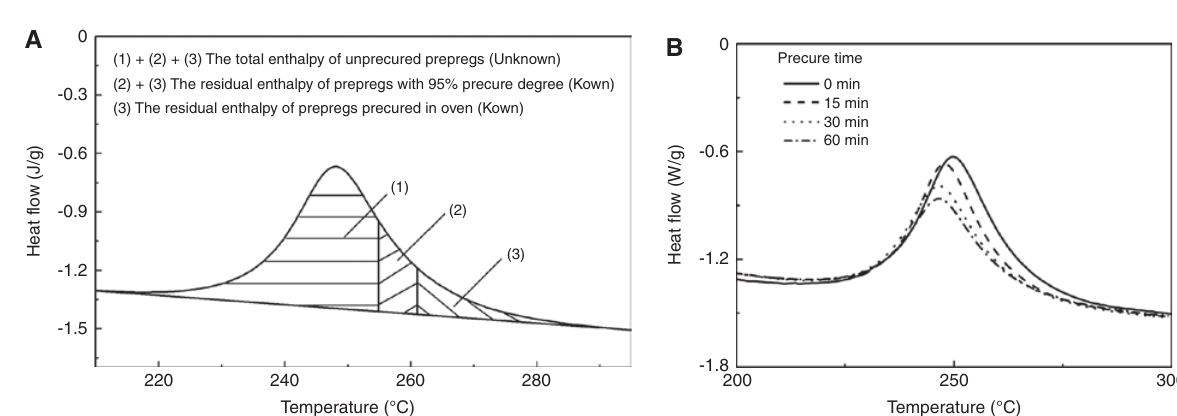
Figure 2: DSC curves for benzoxazine resin (A) showing the total enthalpy of prepregs without precure from a slow temperature scan, (B) showing the residual enthalpy of prepregs for different precure time at 80 °